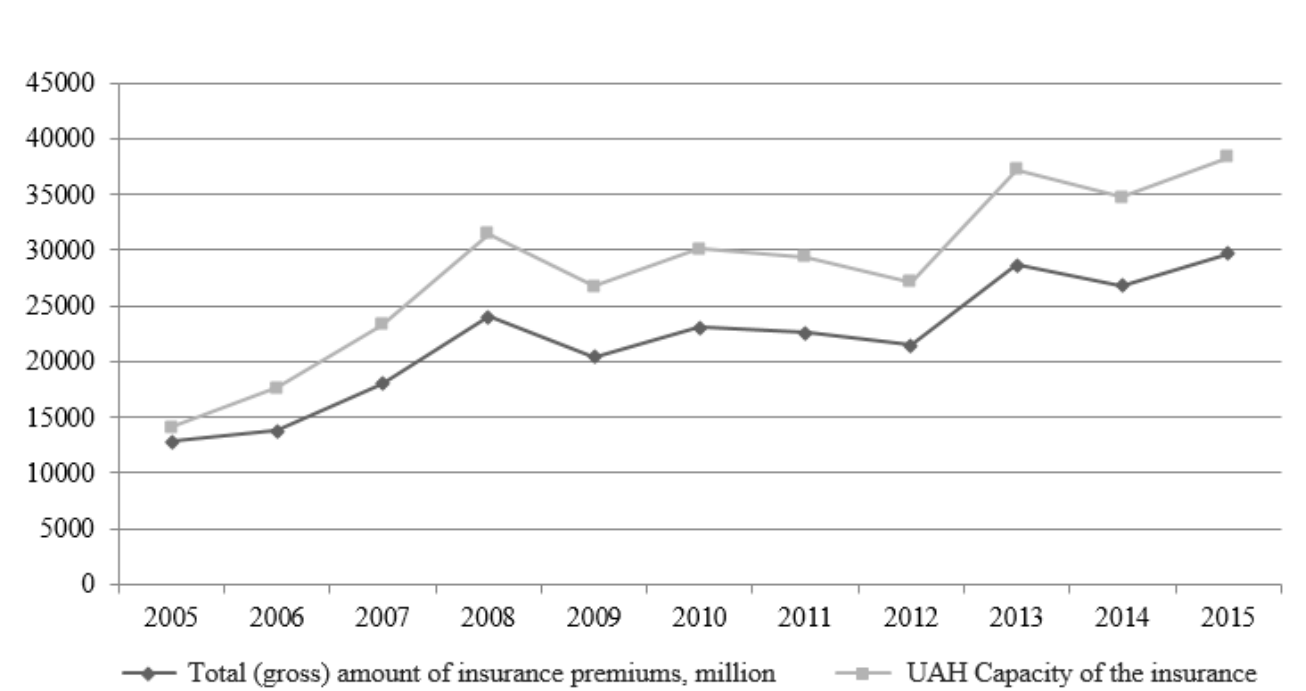
Fig. В .2. The real values of the volume of gross insurance premiums and the estimated values of the insurance ma rket’s capacity for the period 2005 –